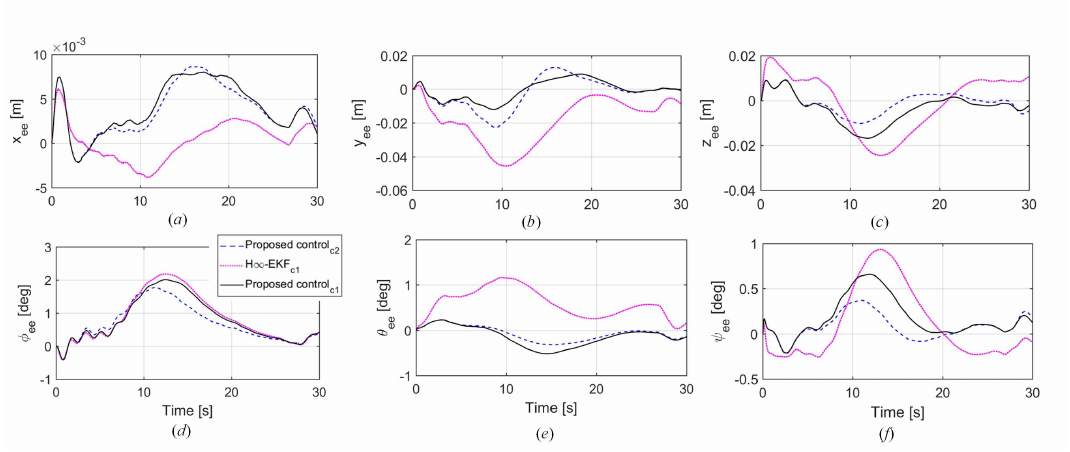
Figure 7. End-effector errors when tracking the linear trajectory. ( a ) x ee error, ( b ) y ee error, ( c ) z ee error, ( d ) tracking errors in the end-effector roll direction, ( e ) tracking errors in the end-effector pitch direction, ( f ) tracking errors in the end-effector yaw